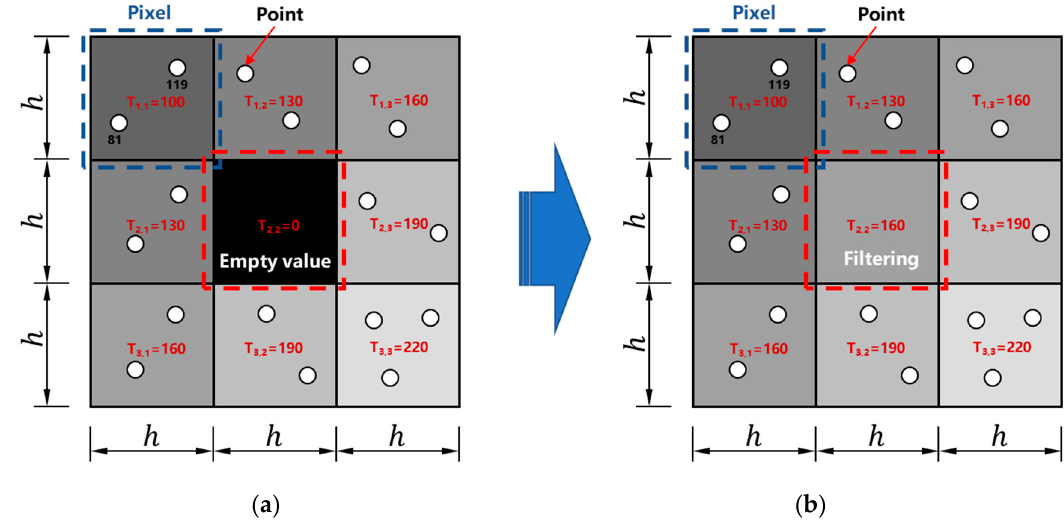
Figure 6. Calculation of grey value of the image: ( a ) before median filtering, and ( b ) after median filtering.